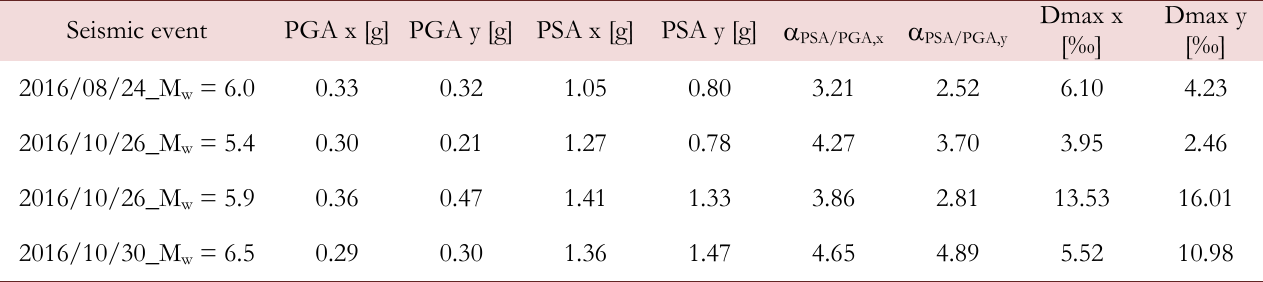
Table 1: Ground motion and structural seismic response for the earthquakes that occurred on August 24 th , October 26 th and October 30 th .